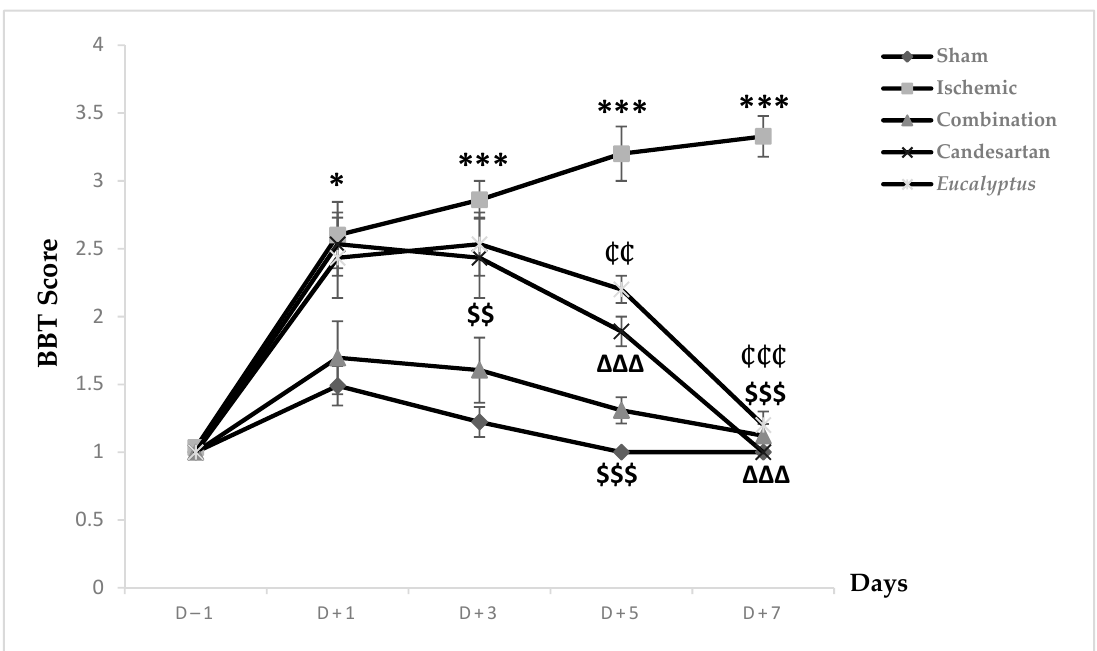
Figure 1. Beam balance test (BBT) scores. BBT scores on days (D) (–1, +1, +3, +5, +7) for the different experimental groups. Sham (n = 6), Ischemic (n = 11), Ischemic treated with a combination of Candesartan and Eucalyptus (n = 10), Ischemic treated with Candesartan (n = 5), and Ischemic treated with Eucalyptus (n = 5). * p < 0.05; *** p < 0.001 for a significant difference between Ischemic and Sham; $$ p < 0.01; $$$ p < 0.01 for a significant difference between Ischemic and Ischemic treated with a combination of Candesartan and Eucalyptus ; ∆∆∆ p < 0.001 for a significant difference between Ischemic and Ischemic treated with Candesartan only; ₵₵ p < 0.01 for a significant difference between Ischemic and Ischemic treated with Eucalyptus only; ₵₵₵ p < 0.01 for a significant difference between Ischemic and Ischemic treated with Eucalyptus only.